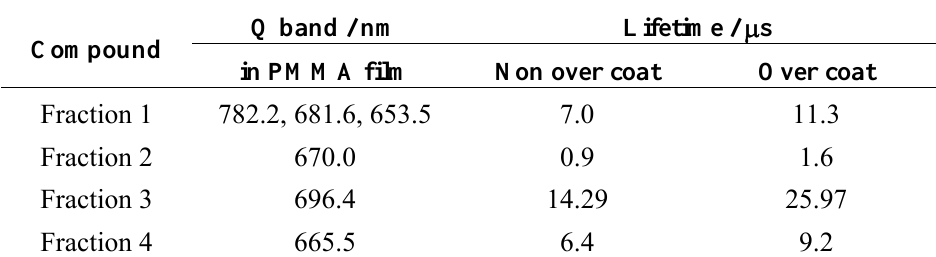
Table 11. Triplet lifetime of each fraction of 5c